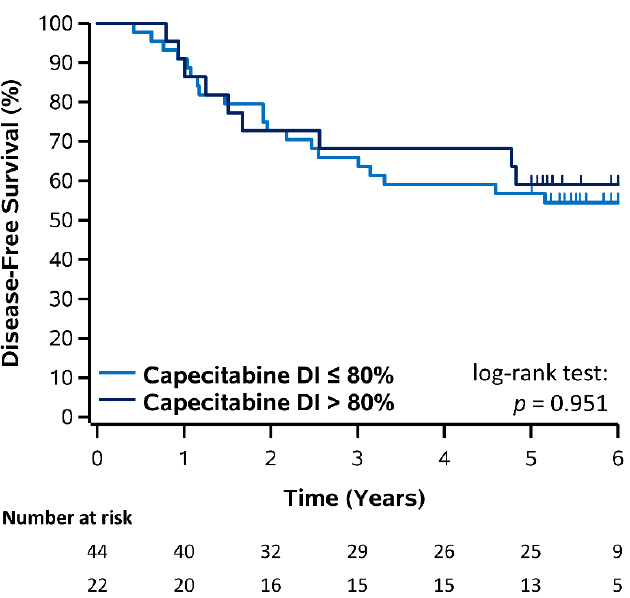
Figure 2. Kaplan–Meier plot of DFS stratified by DI of capecitabine in patients receiving capecitabine.